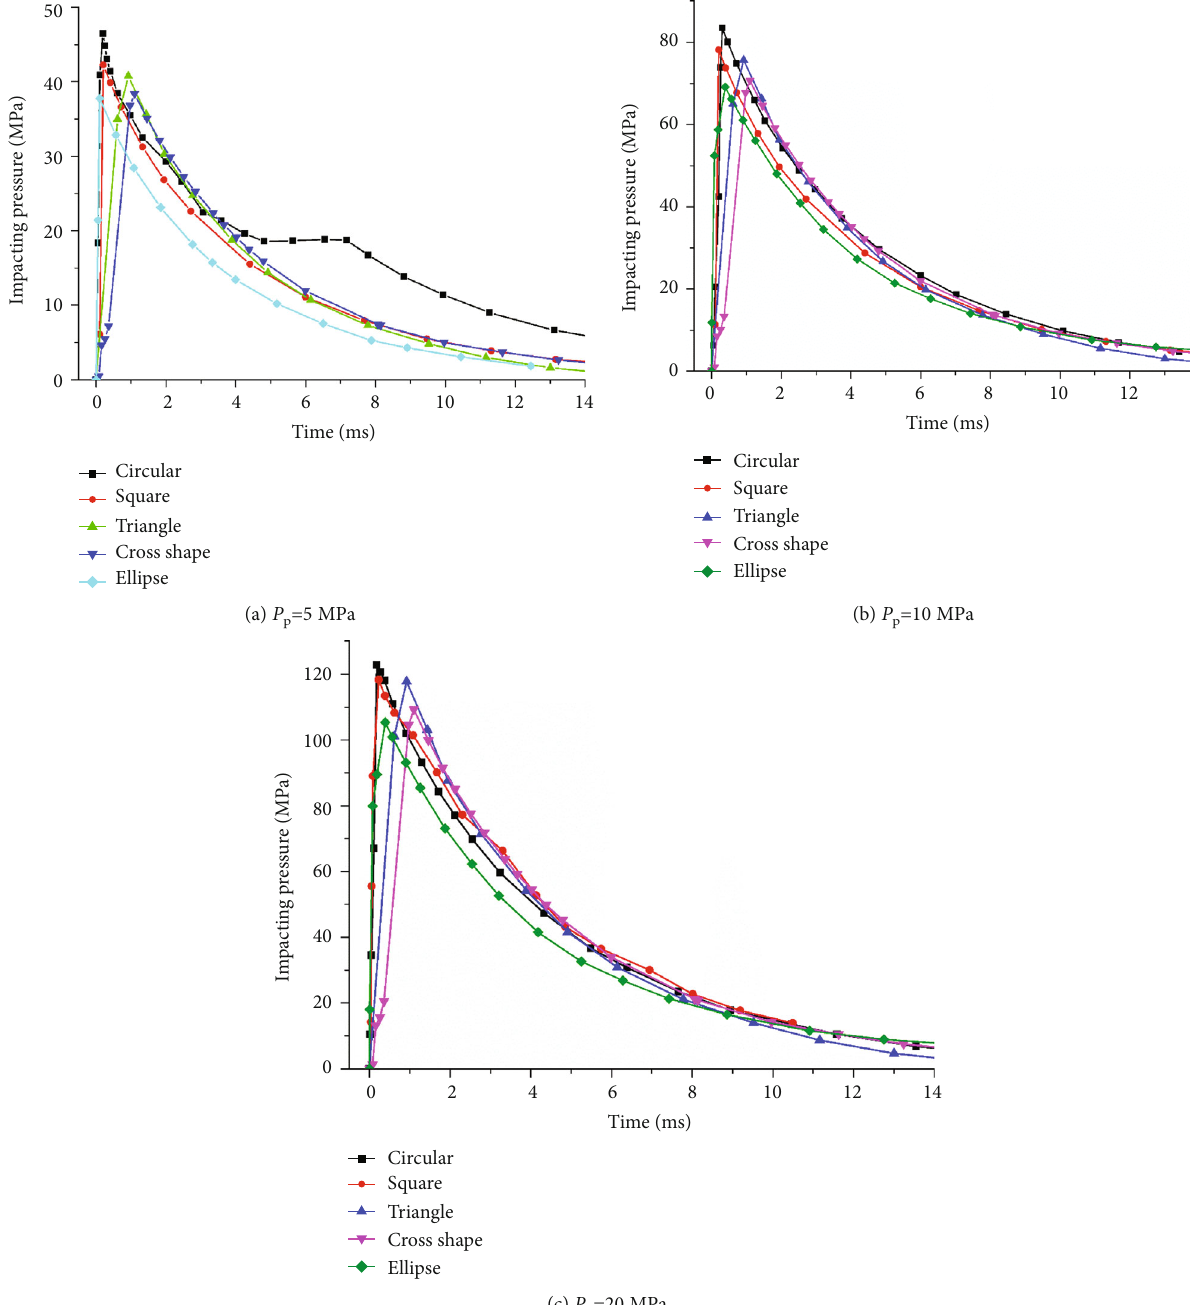
Figure 11: Pressure pro fi les of di ff erent water jets versus